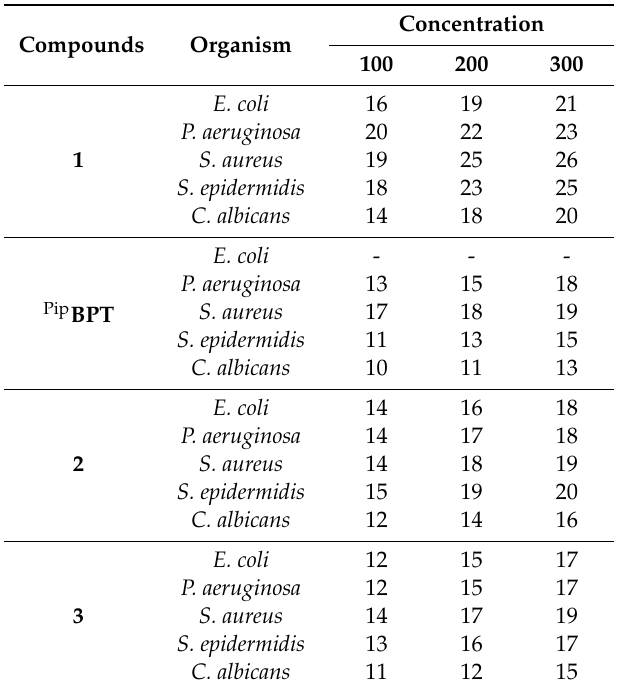
Table 6. Antimicrobial activities of Pip BPT and 1 – 3 at di ff erent concentrations.